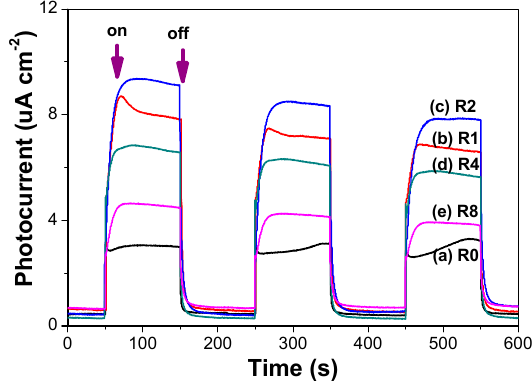
Figure 11. Comparison of the photocurrent response.